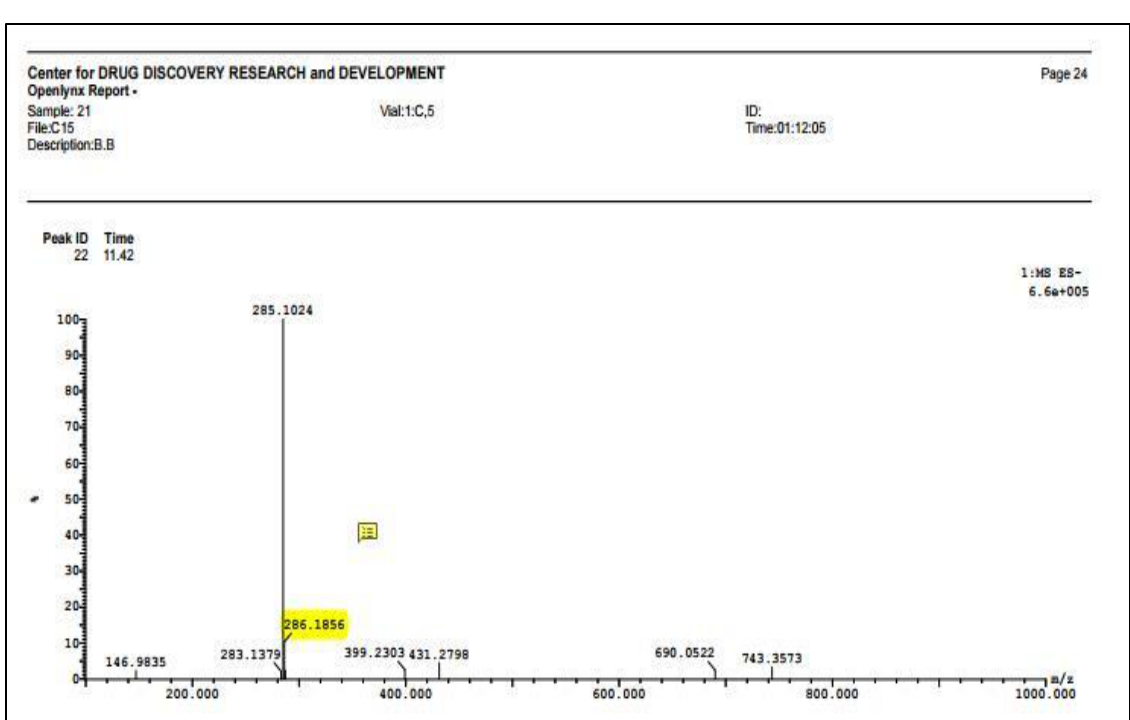
Figure7. Mass 1 of isolated S1 compound in negative ion mode showing M and M-H.